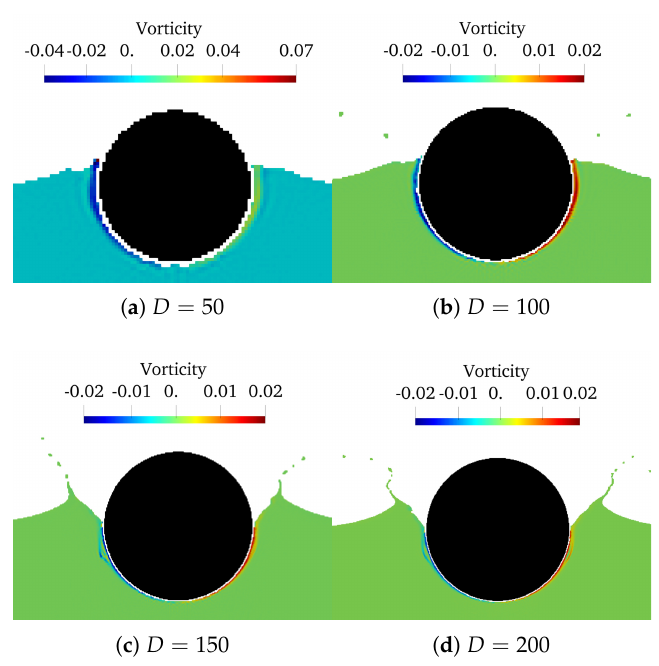
Figure 8. Vorticity plot for different resolution at t (cid:63) = 1.0 for Re = 3660: ( a – d ) the obstacle diameter from 50LU to 200LU,